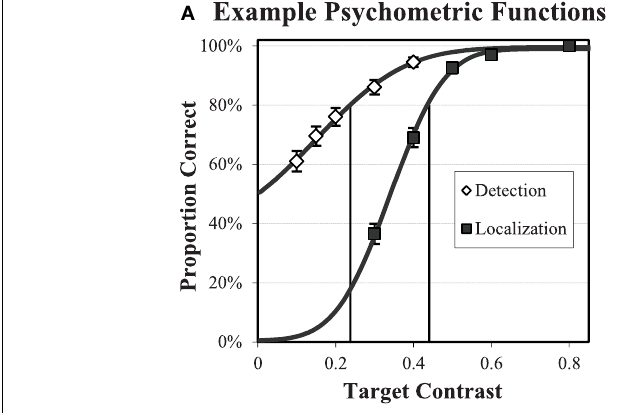
subsequent experiments. The average subject contrast thresholds (B) in each power-law background is shown for both detection and localization tasks. Standard errors across subjects (not shown) are less than 0.01. The localization tasks requires approximately a factor of 2 greater contrast to obtain equivalent (80% correct) performance.